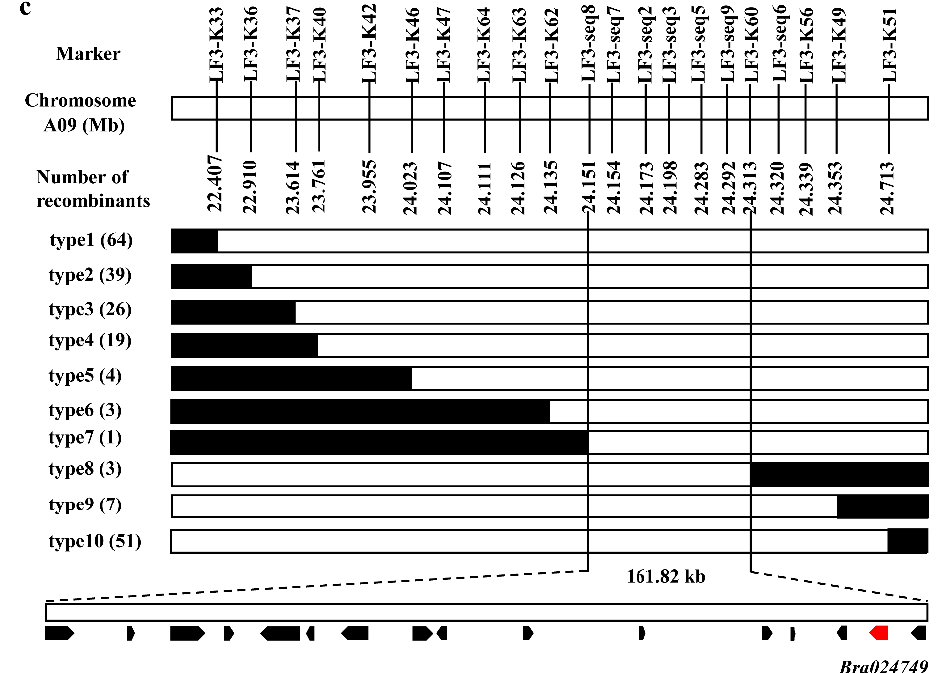
Figure 3. Map-based cloning of BrWAX3 gene in Chinese cabbage. ( a ) BSA-seq analysis for BrWAX3 . The Δ (SNP-index) was calculated at 1-Mb intervals with a 50-kb sliding window. One candidate region was identified on chromosome A09. ( b ) Initial mapping of BrWAX3 . The genetic map of BrWAX3 was showed with cM as the unit. ( c ) Fine mapping of BrWAX3 . The BrWAX3 gene was delimited to an interval between LF3-seq8 and LF3-K60 on chromosome A09, with an estimated physical length of 161.82 kb, and 16 genes were annotated in this region based on the reference genome sequence. The genetic structure of each recombinant type is depicted as white for homozygous glossy phenotype, black for heterozygous alleles, respectively. The number of each recombinant type is indicated in the brackets.